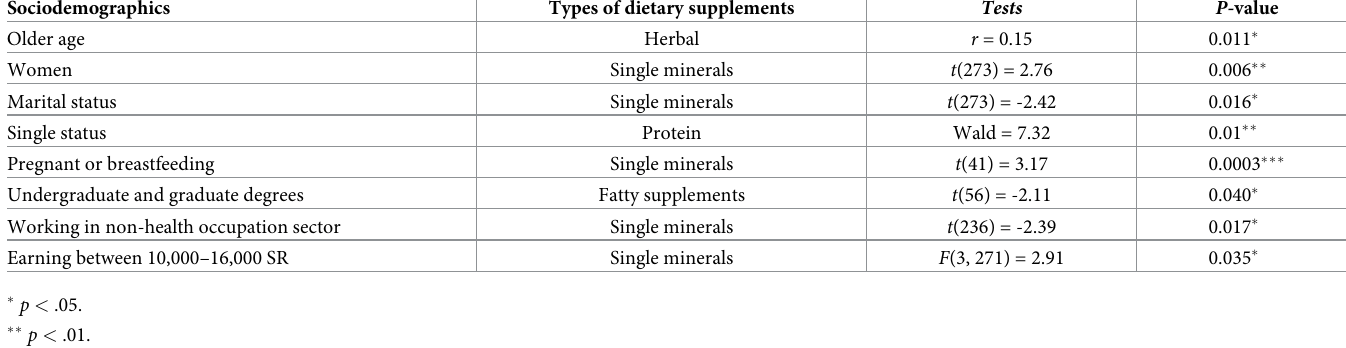
Table 2. Significant association between sociodemographics and different types of dietary